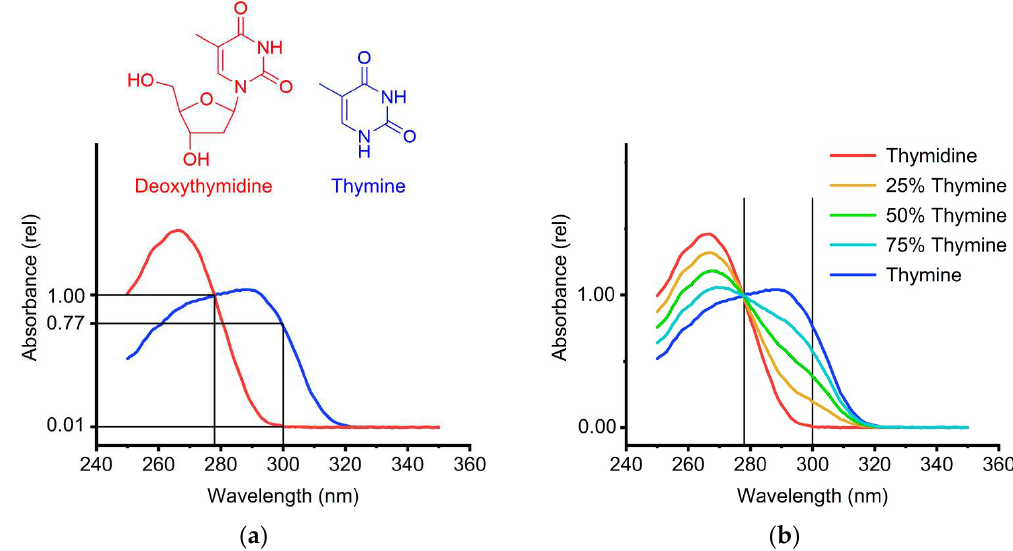
Figure 2. Comparison of absorption spectra of deoxythymidine and thymine in alkaline dilutions. Absorption spectra of deoxythymidine and thymine were recorded as described in Materials and Methods in an alkaline dilution at pH 13. The isosbestic point of deoxythymidine/thymine mixtures at 277 nm and the point for determination of the deoxythymidine/thymine ratio at 300 nm are indicated on the x axis. ( a ) The spectra of pure deoxythmidine (red curve) and pure thymine (blue curve) differ significantly when measured in an alkaline dilution. The Abs 300/277 ratios of pure deoxythymidine (Abs 300/277 (deoxythymidine) ≈ 0.77) and pure thymine (Abs 300/277 (thymine) ≈ 0.01) are indicated on the y axis. The exact values are given in Materials and Methods. Both spectra are shown normalized to the isosbestic point at 277 nm; ( b ) comparison of absorption spectra of pure deoxythmidine, thymine, and indicated mixtures, measured in an alkaline dilution. Abs 300/277 increases linearly with increasing thymine mole fraction (given as percentage; from red to blue).